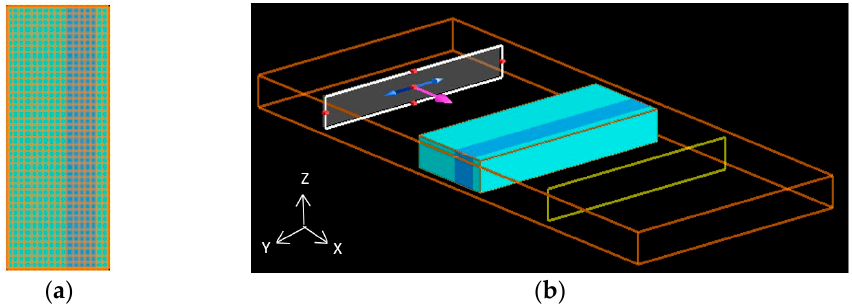
Figure 1. ( a ) Schematic structure of ARC with the meshing of XY plane. ( b )The full structure of simulation procedure at three dimensions by FDTD, which consist of plane wave source (white color), the designed structure (sky and blue color), the monitor (yellow color), and FDTD domain (orange color).